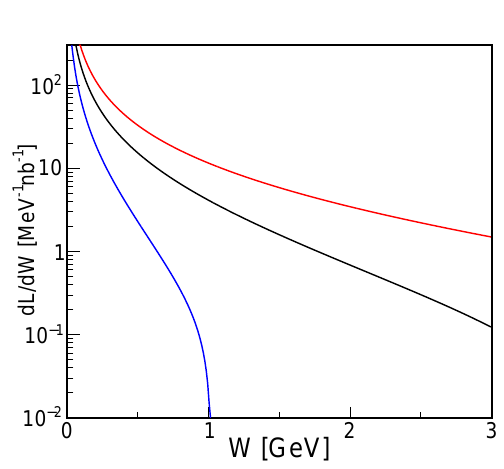
Figure 3. Di ff erential γγ luminosity dL / dW in e + e − for L ee = 1 fb − 1 as function of c.m. energy of the two photons W : red line – √ s = 10 GeV (Belle), black line – √ s = 1 . 02 GeV blue line